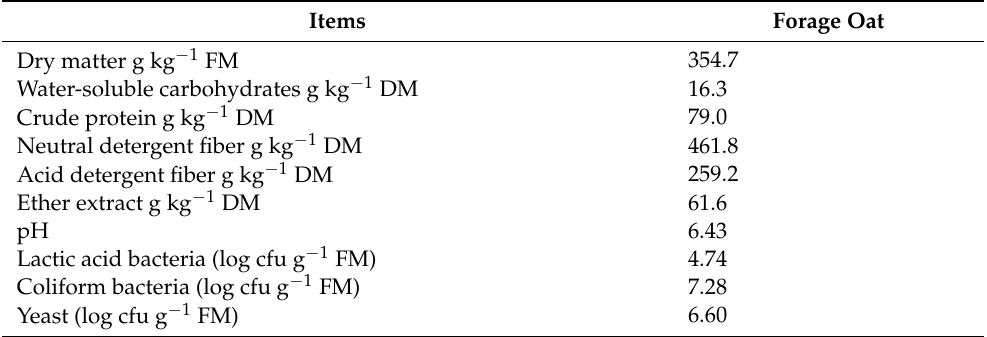
Table 1. Chemical composition and microbial population of oat by plate culture before ensiling. Items Forage Oat Dry matter g kg − 1 FM